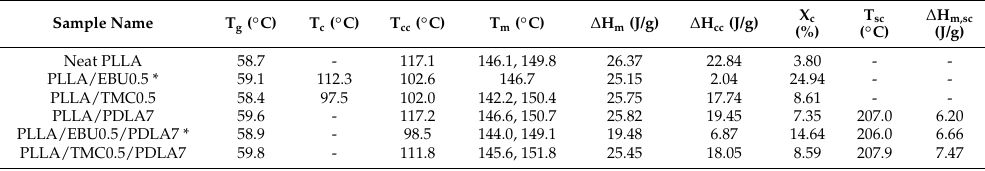
Table 2. Thermal characteristic of nucleated PLLA as determine by second heating